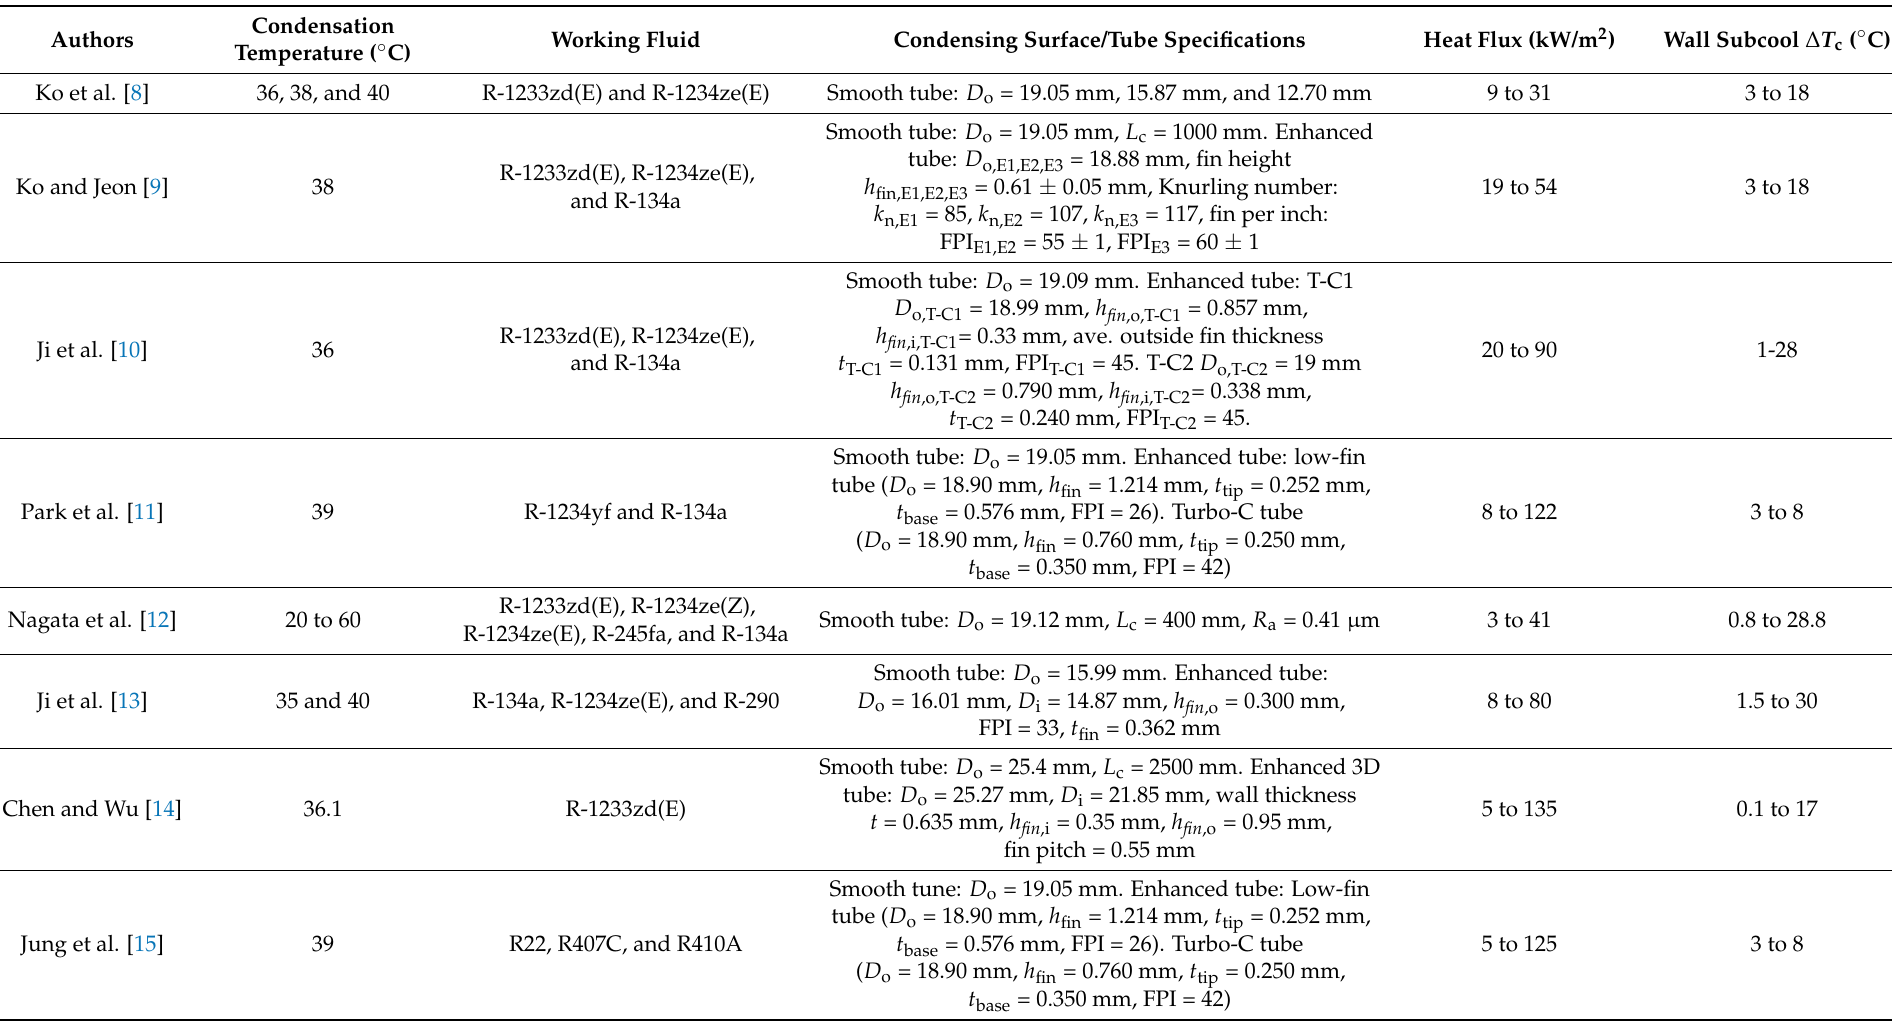
Table 2. Dimensions/specifications of smooth/enhanced tube and experimental conditions reported in the